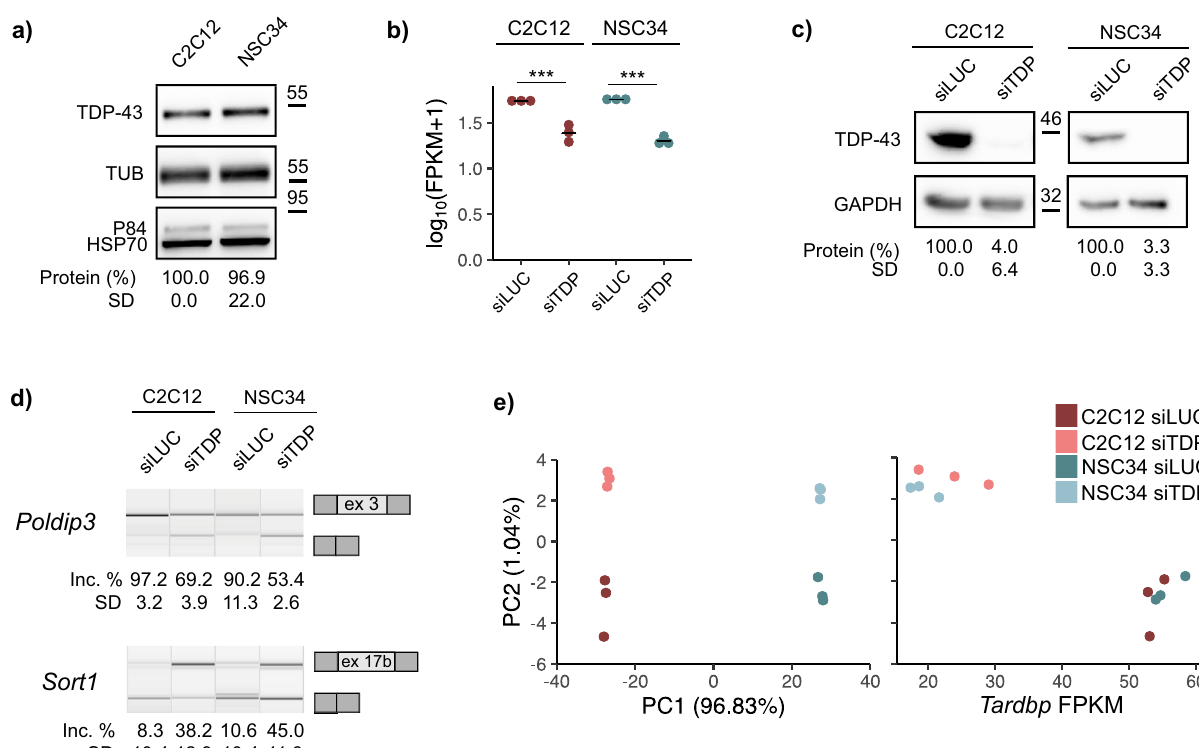
Fig. 1 TDP-43 expression and functional consequences of TDP-43 silencing in C2C12 and NSC34 cells. a Western blot shows similar expression of endogenous TDP-43 in C2C12 and NSC34 cells. The amount of TDP-43 was normalized to the sum of peak intensities of 3 loading controls (tubulin, HSP70 and P84) ( n = 3 replicates per group). b Expression levels of Tardbp in TDP-43-silenced C2C12 and NSC34 and corresponding controls assessed by RNA-sew plotted as log 10 -transformed FPKM values show TDP-43 was depleted (on the mRNA level) to the same extent in both cell lines ( n = 3 replicates per group). p adj = 1.6·10 − 18 for C2C12 and p adj = 2.3·10 − 72 for NSC34. p -values were generated using Wald test and Benjamini – Hochberg multiple